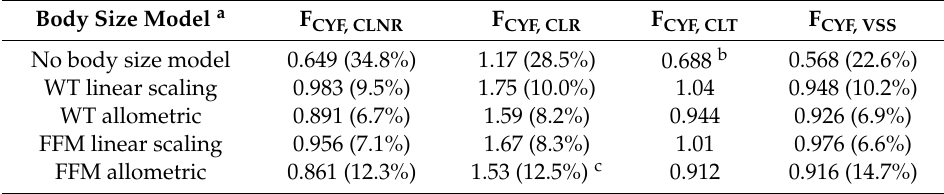
Table 4. Disease specific scale factors which represent the clearance (or volume of distribution) in patients with CF divided by that in healthy volunteers after accounting for body size and body composition by the respective size